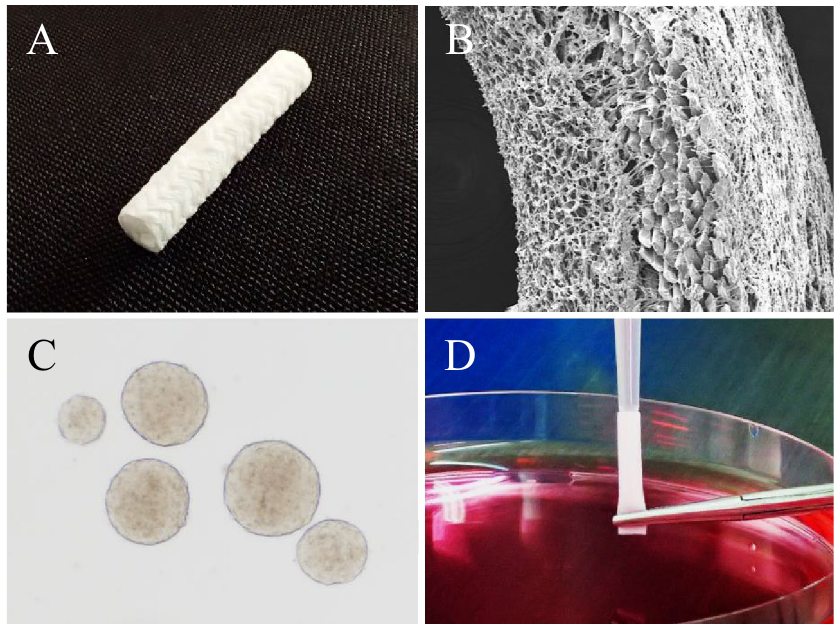
Figure 1. ( A ) Gross appearance of the bioabsorbable nerve conduit. ( B ) Scanning electron microscope image of a cross-section of the two-layered conduit; the inner layer has a honeycomb structure that functions as a scaffold. ( C ) Neurospheres derived from the hiPSCs. ( D ) Seeding of the hiPSC-derived neurospheres into the nerve conduit in